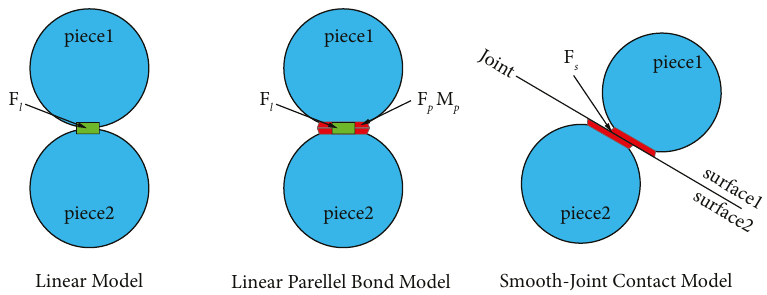
Figure 7: Contact model